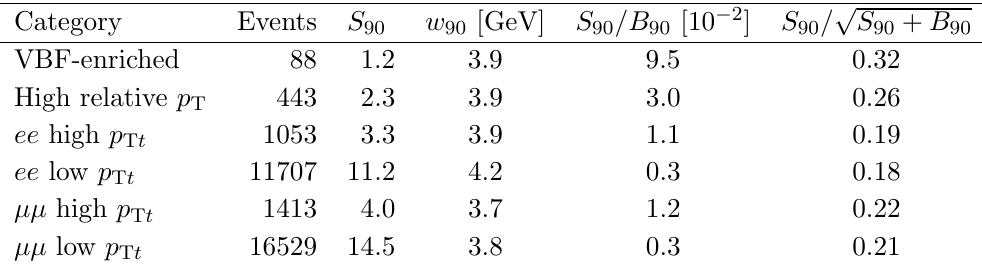
Table 3 . The number of data events selected in the mass range used for the background (cid:12)t to the m Z(cid:13) spectrum (115-150 GeV) per category. In addition, the following numbers are given: the expected number of Higgs boson signal events in an interval around the peak position for a signal of m H = 125 : 09 GeV, expected to contain 90% of the SM signal ( S 90 ), the half-width of the S 90 interval ( w 90 ), as well as the expected signal-to-background ratio in the S 90 window ( S 90 =B 90 ) with p B 90 determined from data, and the expected signi(cid:12)cance estimate S 90 = S 90 + B 90 . summarises for each category: the number of selected events from data in the (cid:12)t range 115 GeV < m < 150 GeV (see section 5); the expected number of events ( S ) in an 90 Z(cid:13) interval around the m peak position expected to contain 90% of the SM signal Z(cid:13)